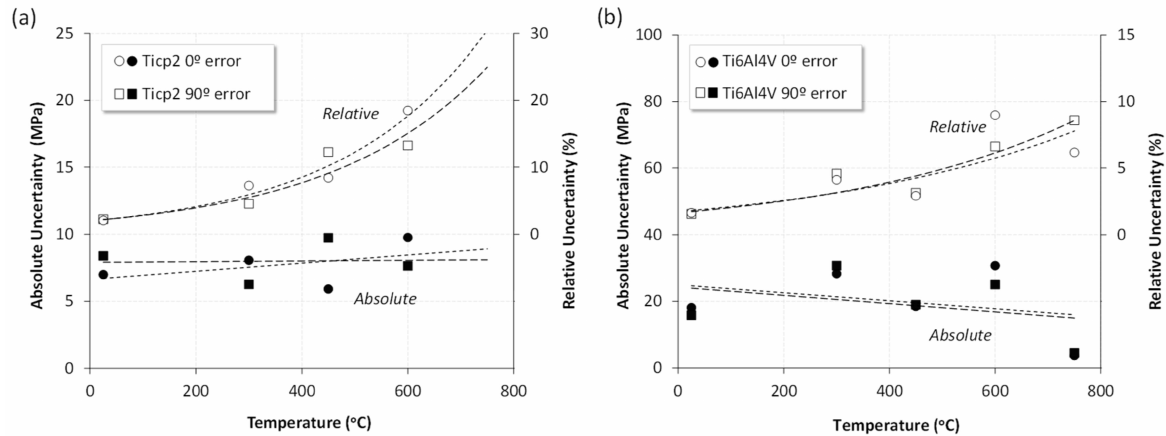
Figure 10. Average relative and absolute typical uncertainty as a function of the temperature. ( a ) Ticp-2; ( b )